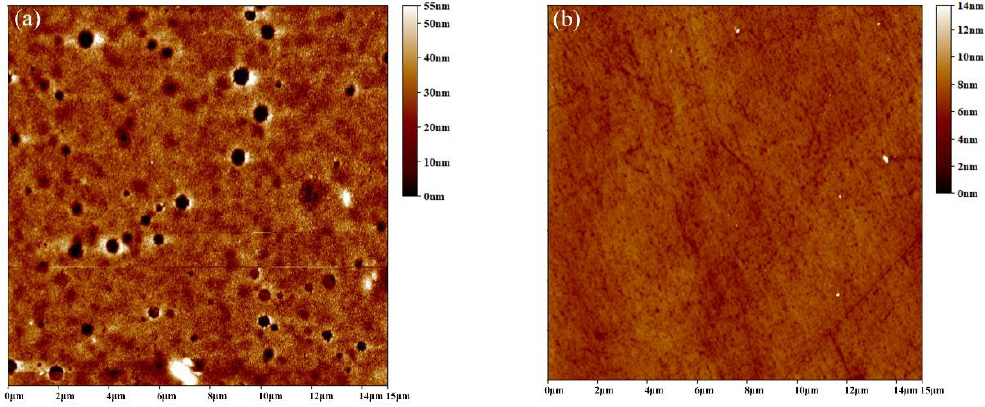
Figure 3. Atomic force microscopy (AFM) images of ( a ) indium tin oxide (ITO)/ZnO/CdS/CdTe and ( b ) ITO/ZnO/CdS/CdTe/Spiro thin films.